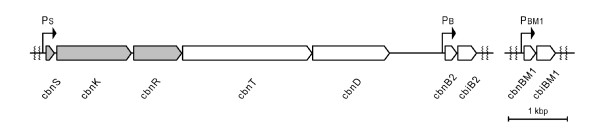
Gene loci involved in carnobacteriocin B2 and BM1 production and immunity. The locus in the plasmid pCP40 (left) contains the cbnS-cbnK-cbnR three-component regulatory system gene cassette (genes colored in gray), cbnT and cbnD, encoding a peptide autoinducer and peptide antibiotic secretion/processing system, cbnB2, encoding the precursor of carnobacteriocin B2, and cbiB2, encoding carnobacteriocin B2 immunity protein. The chromosomal locus (right) includes cbnBM1, encoding the precursor of carnobacteriocin BM1, and cbiBM1, encoding carnobacteriocin BM1 immunity protein. The positions of the promoters PS, PB, and PBM1 are shown.